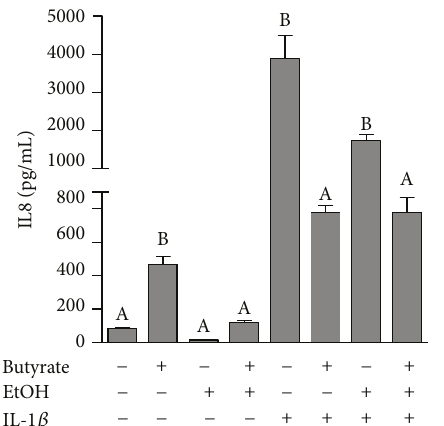
Figure 3: E ff ect of butyrate on secreted IL-8 from Caco-2 monolayers stimulated with IL-1 β and ethanol. Human intestinal epithelial cells (Caco-2) were grown to con fl uency in 24-well plates, and monolayers were allowed to di ff erentiate for 7 days. Cells were pretreated ± sodium butyrate (5 mM) for 18 h and then challenged with 25 mM ethanol and/or 10 ng/mL IL-1 β for 3 h. Extracellular media was then collected and analyzed for IL-8 by ELISA. Treatments were performed in duplicate and repeated four times. Data are mean ± SEM . Values with di ff erent alphabetical superscripts were signi fi cantly di ff erent from each other, p < 0 05